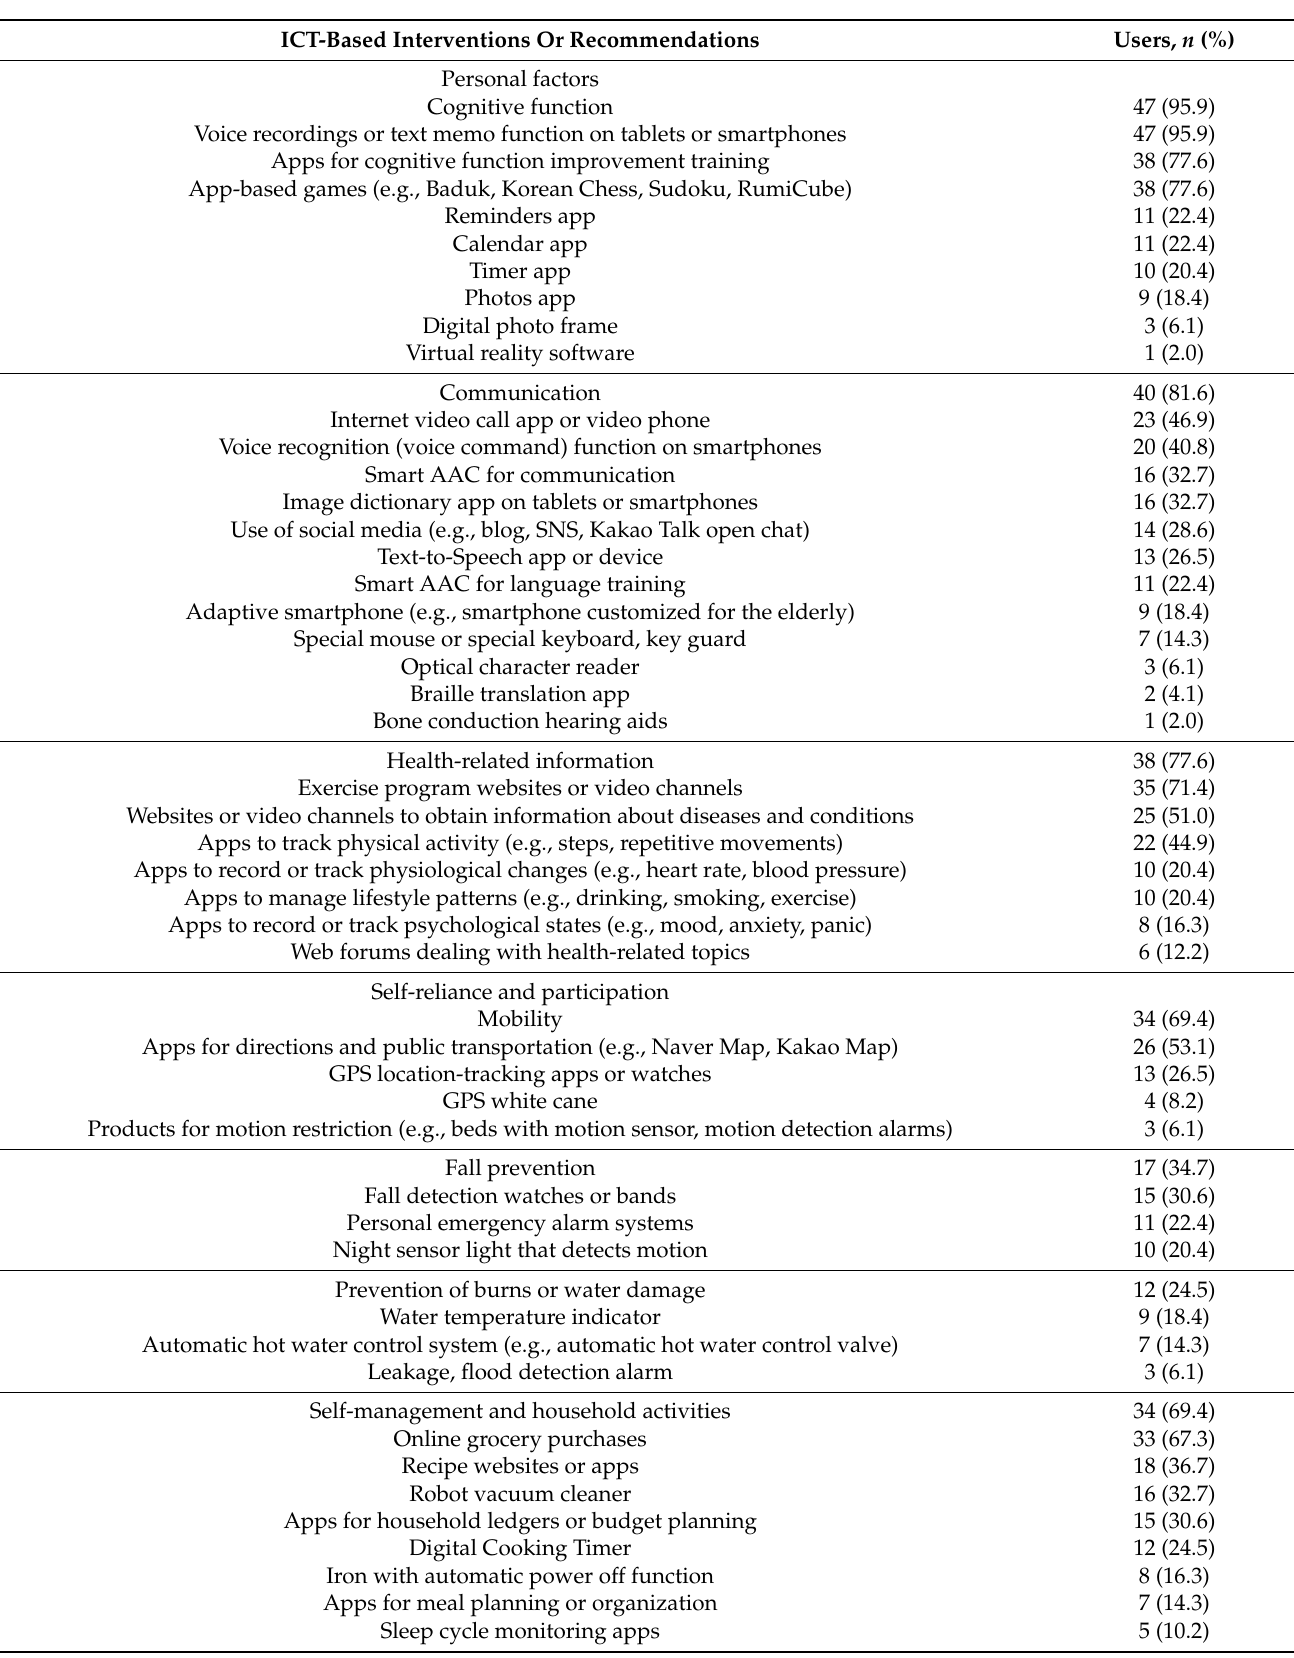
Table 2. Percentages of ICT applied by familiar users ( n =